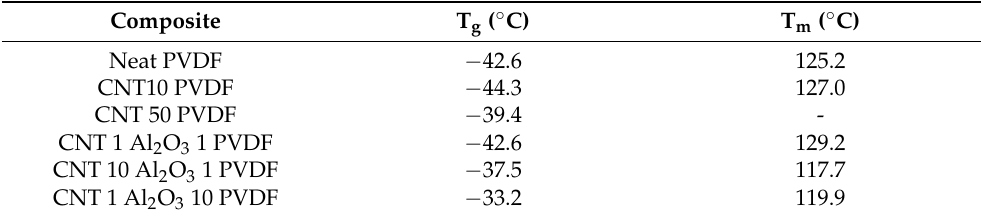
Figure 9. DMA plots comparing the ( a ) effect of alumina wt.% on storage modulus of the PVDF nanocomposites at an oscillatory frequency of 1Hz under tension. Tan delta peaks show ( b ) dynamic Tg between −55 °C and −20 °C and ( c ) T m between 105 °C and 140 °C. Table 4. Summary of glass transition temperature (T g ) and melting temperature (T m ) measured using DMA at 1